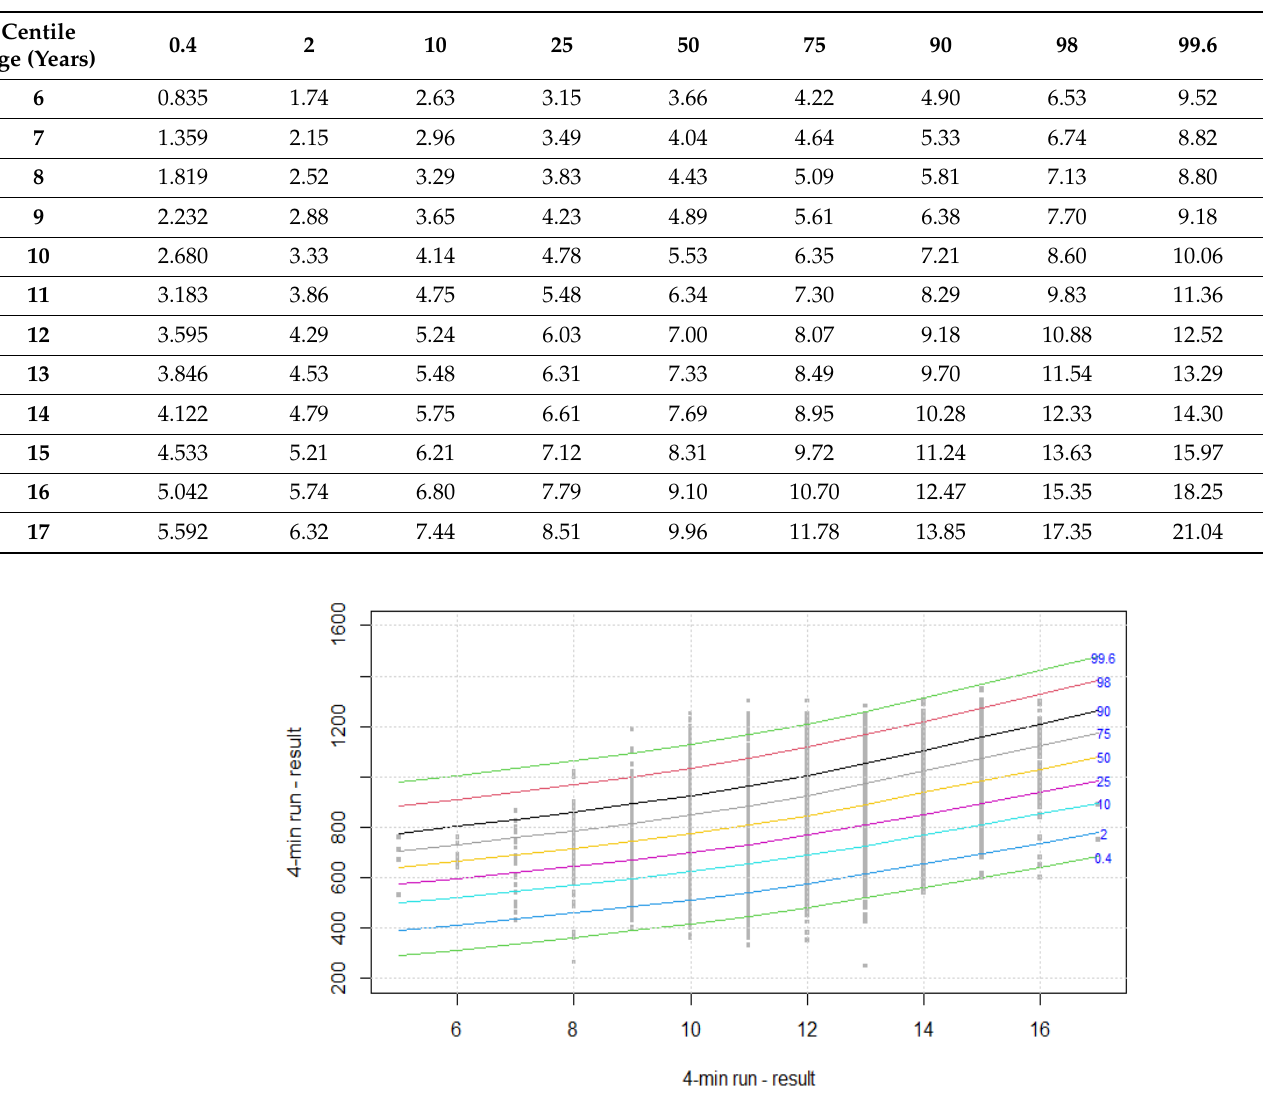
Figure 7. Centile chart for 4-min run in boys. Table 10. Values of particular centiles for 4-min run in boys.